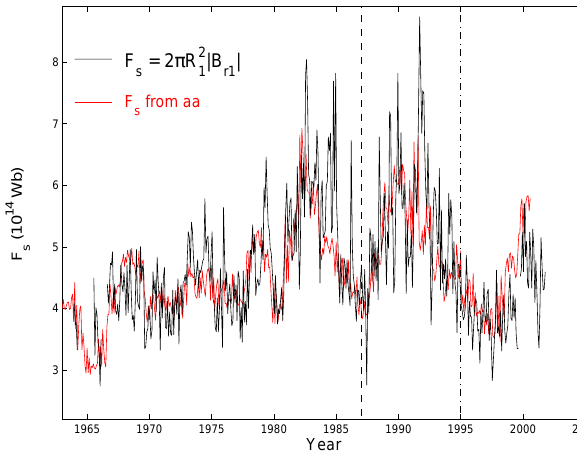
Fig. 2. Monthly values of the open solar flux F s . The black line shows monthly means deduced from IMF observations [ F s ] = 2 πr 12 | B r | , whereas the red curve shows 1-year values IMF 1 deduced from the aa geomagnetic index [ F s ] aa , using the method of Lockwood et al. (1999). The vertical dashed line shows the end of the data interval used by Lockwood et al. in the development of the procedure and the dot-dash line shows the end of the test data presented by these authors. It can be see that the procedure has continued to work well for the additional test data accrued during